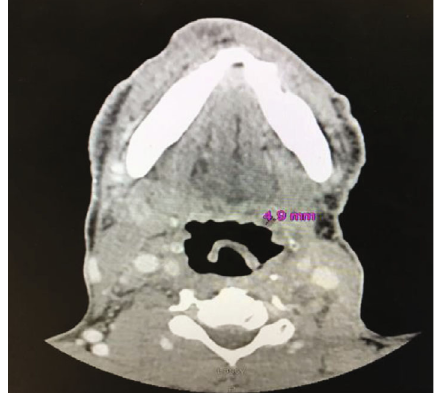
Figure 3: CT neck with contrast imaging of left nasal